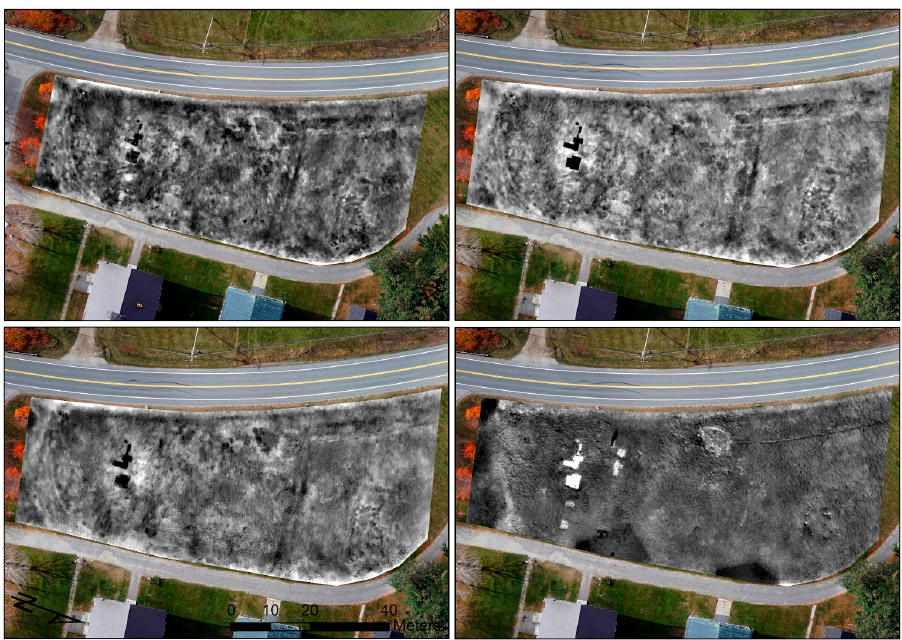
Figure 6. Thermal maps of the main lawn at the Enfield Shaker Village from four flights across one night, May 11–12, 2017 at 60 m. ( top left ): 8 p.m.; ( top right ): 11.p.m.; ( bottom left ): 4 a.m.; ( bottom right ): 9 a.m.